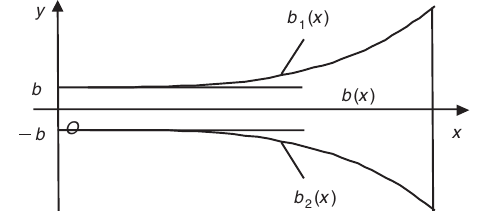
Figure 3 Configuration of a caudal fin.